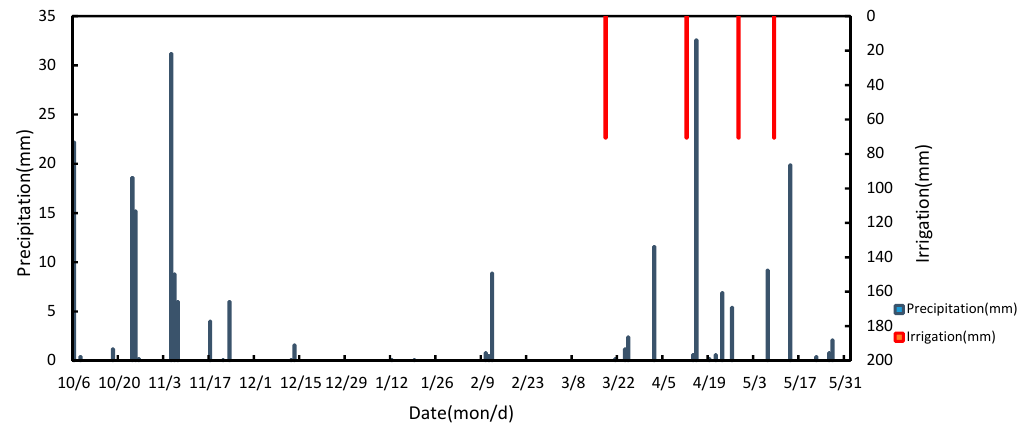
Figure 3. Precipitation and irrigation during the growth period of winter wheat.